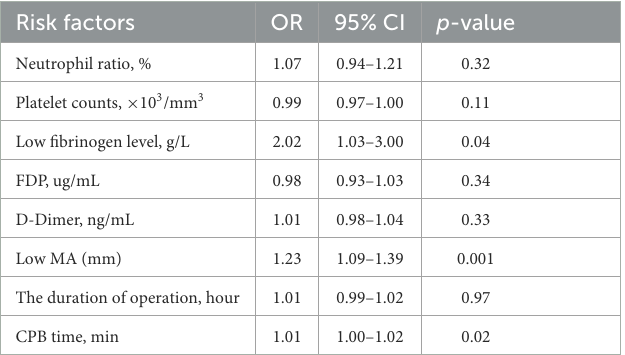
TABLE 3 Risk factors for postoperative AKI (stage 3) in multivariate logistic regression analysis in patients with ATAAD.